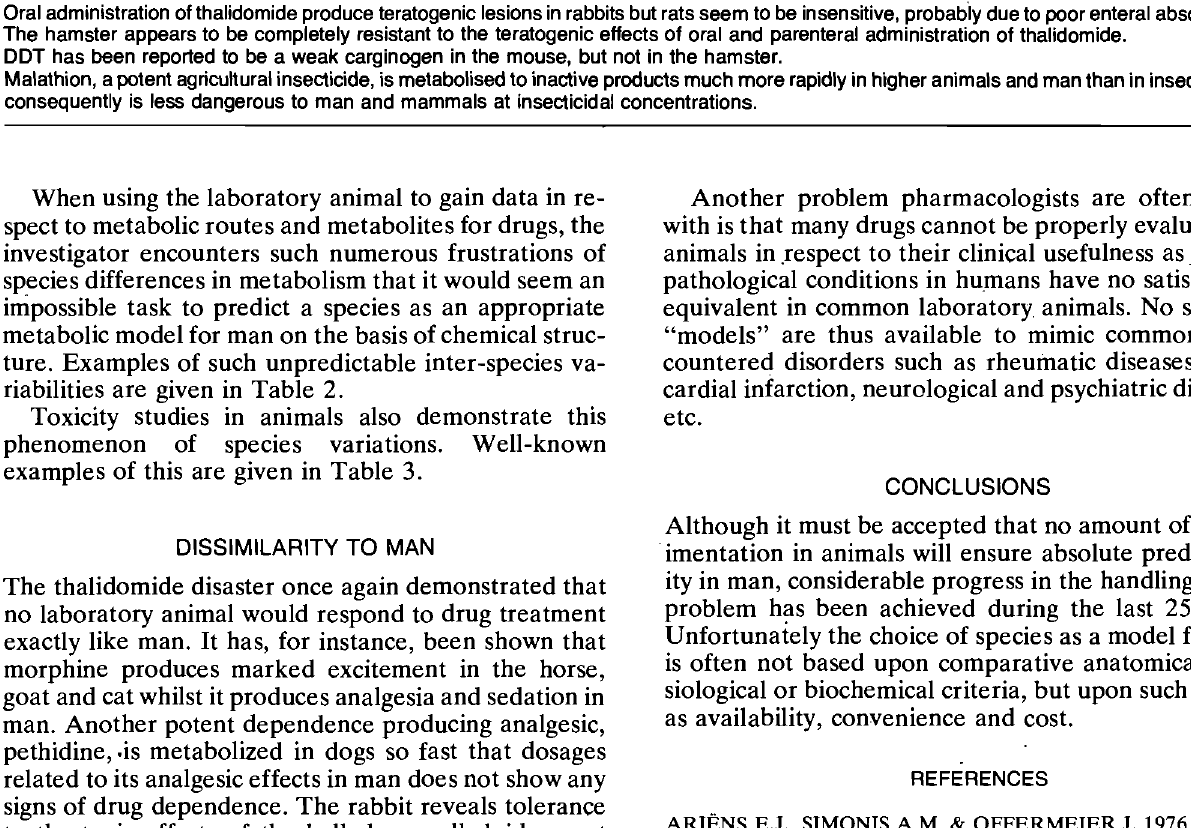
Table 3: EXAMPLES OF SPECIES DIFFERENCES ENCOUNTERED IN TOXICOLOGICAL STUDIES Oral administration of thalidomide produce teratogenic lesions in rabbits but rats seem to be insensitive, probably due to poor enteral absorption, The hamster appears to be completely resistant to the teratogenic effects of oral and parenteral administration of thalidomide. DDT has been reported to be a weak carginogen in the mouse, but not in the hamster. Malathion, a potent agricultural insecticide, is metabolised to inactive products much more rapidly in higher animals and man than in insects, ant consequently is less dangerous to man and mammals at insecticidal